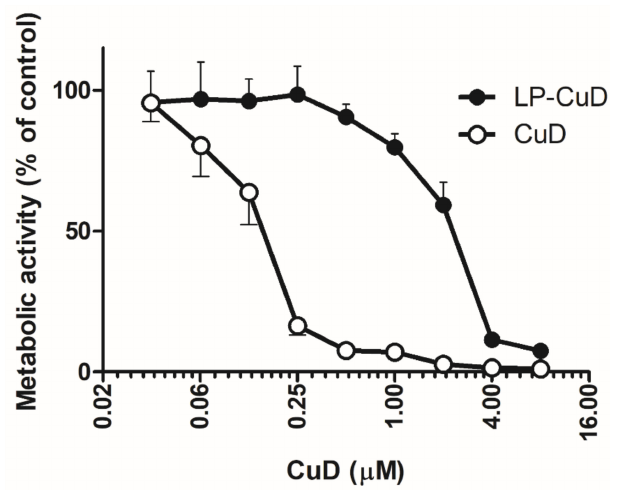
Figure 3. In vitro cytotoxic activity of LP-CuD and free CuD in mitogen-activated murine spleen cells. The cells were isolated from spleens of normal BALB/c mice, plated at 100,000 cells/well in 96-well plates, and activated by 5 mg · mL − 1 concanavalin A. Concurrently, the LP-CuD and the parent free drug were added at a series of concentrations. Overall metabolic activity of the cells was determined using the standard MTT method after 72 h of cultivation and is expressed as a percentage of the control value (cells with concanavalin A). The IC 50 values were calculated for the polymer conjugate and the free drug, equal to 2.39 µ M CuD equivalent and 0.16 µ M CuD, respectively. Four parallel samples per condition were